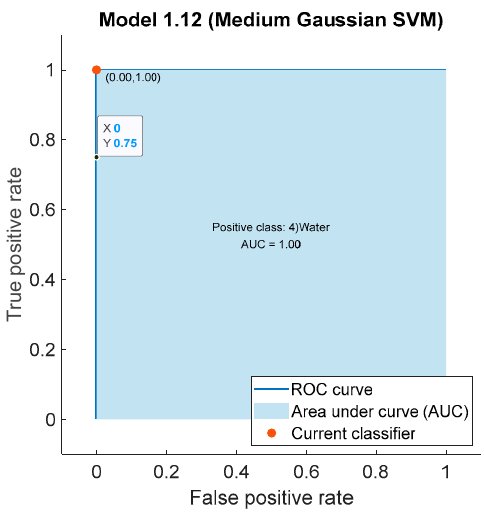
Figure 7. ROC-AUC curve for the medium Gaussian–SVM model for classifying different types of pesticides against distilled water samples.